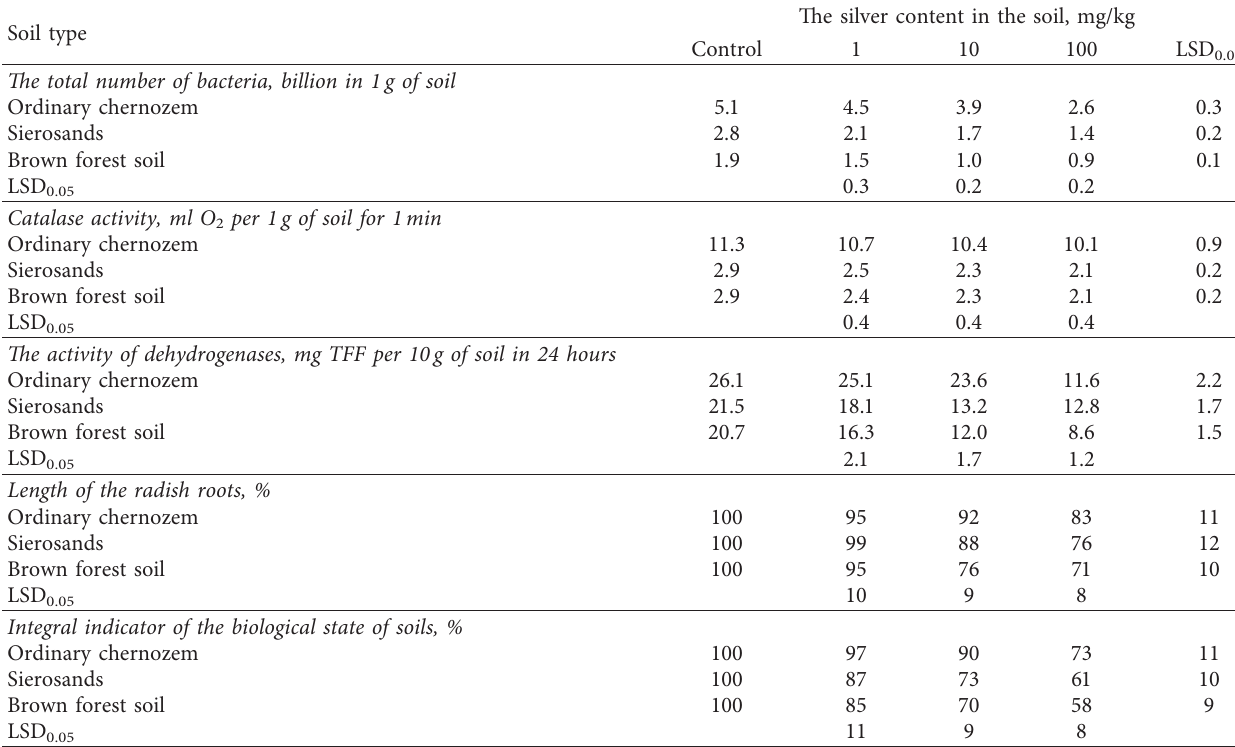
The silver content in the soil, mg/kg